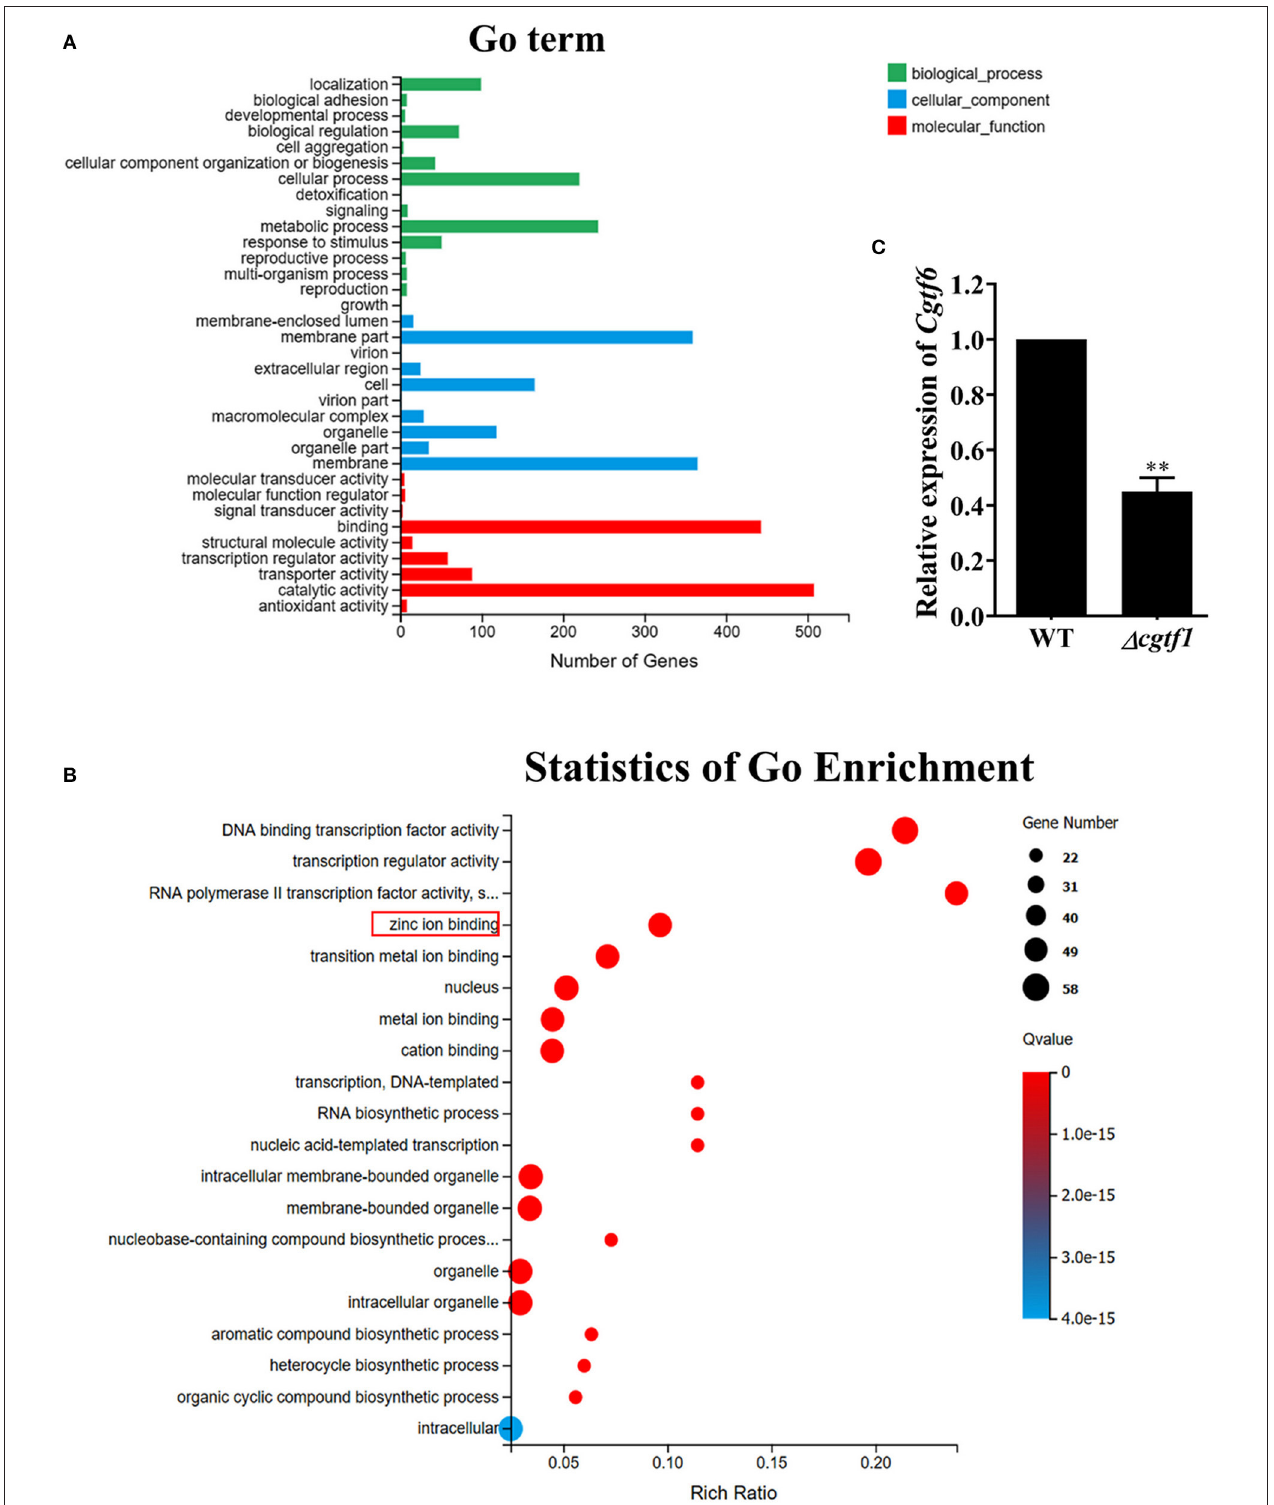
FIGURE 4 | RNA-Seq Profiling identifies a novel Cys 2 His 2 transcription factor CgTF6 regulated by CgTF1. (A) GO annotation of differentially expressed genes between Cgtf1 null mutant and the wild-type of C. globosum strain. (B) Statistics of GO enrichment of differentially expressed in GO term of transcription regulatory activity. (C) Gene expression of Cgtf6 in the wild-type (WT) and the ∆ cgtf1 -10. Transcripts of Cgtf6 was normalized against GAPDH . Experiments were performed in triplicate. There is significantly difference between the WT and ∆ cgtf1-10 as indicated by two asterisks ( p -value < 0.01, with T -test analysis).